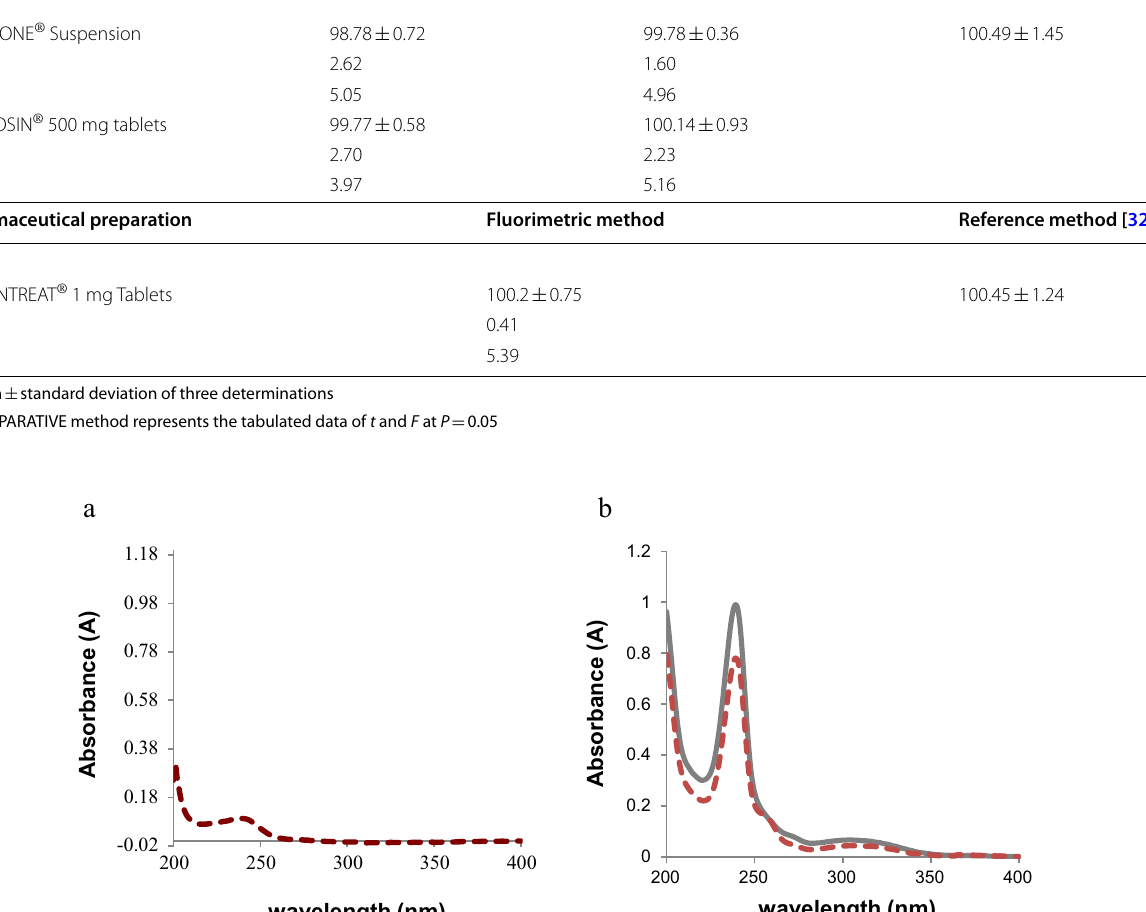
Fig. 2 a Absorption spectra of 10 μg/mL AZN in methanol and b Absorption spectra of 50 μg/mL CDs and 20 μg/mL AZN after interaction with CDs in deionized